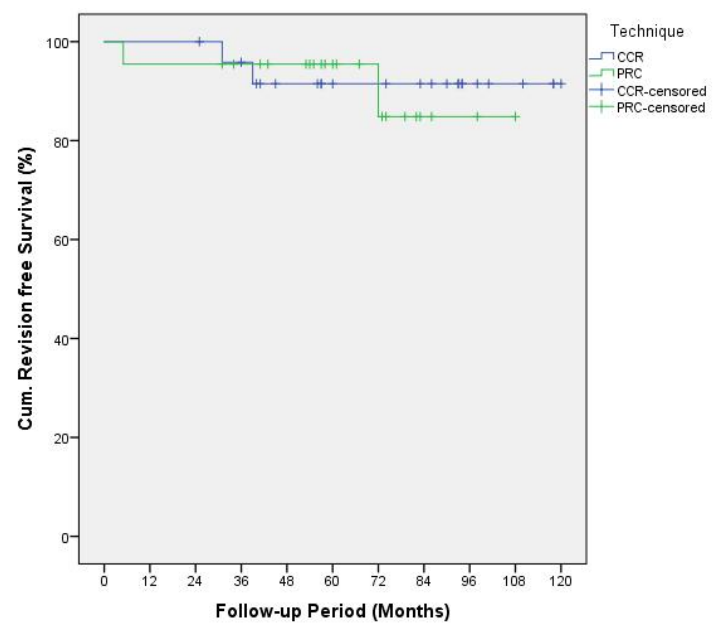
Figure 4. Kaplan–Meier Plot displaying cumulative revision-free survival functions.